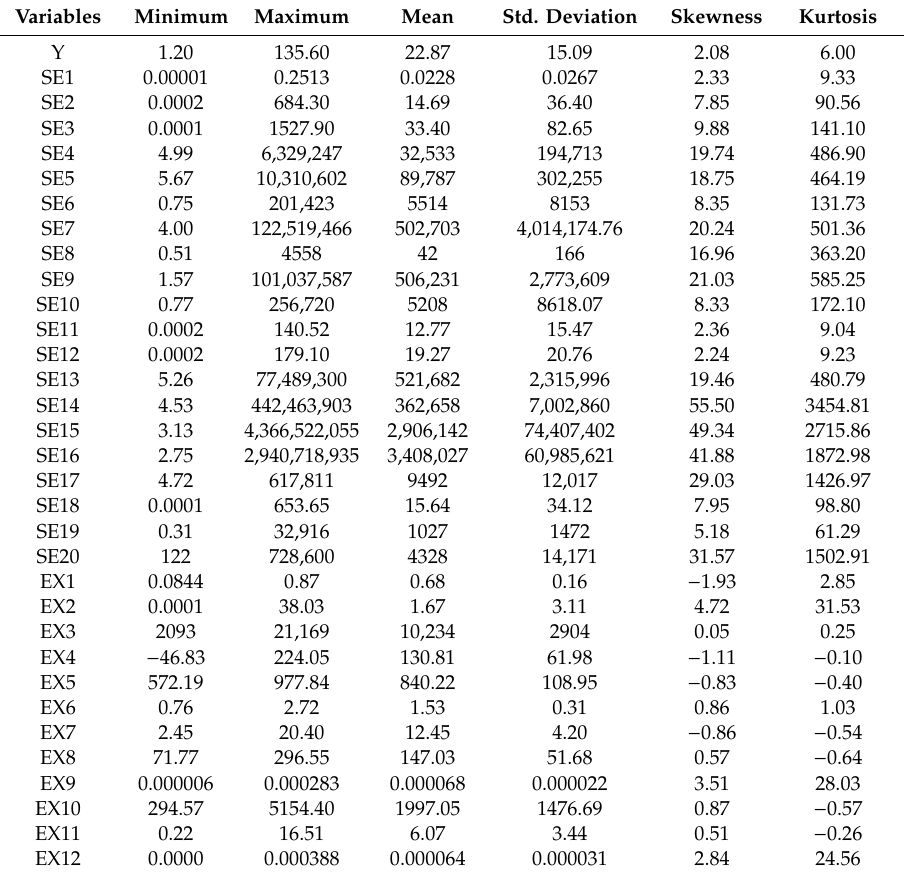
Table A1. Descriptive statistics of the modeling data.